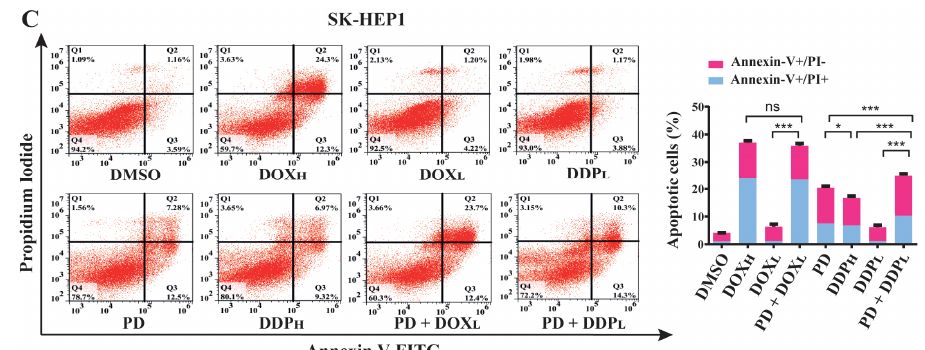
Figure 3. Evaluation of apoptotic rates in normal liver HL ‐ 7702 cells ( A ), HCC HepG2 ( B ) and SK ‐ HEP1 ( C ) cells using PD (300 μ M) and PD in combination with high or low dosages of DOX (0.2 and 1.5 μ M, as DOX L and DOX H , respectively) and DDP (5 and 30 μ M, as DDP L and DDP H , respectively). The cells were seeded and cultured overnight, and then treated by PD, DOX L , DOX H , DDP L and DDP H individually or combinatorially (PD + DOX L and PD + DDP L ) for 48 h. The cells were stained with Annexin V ‐ FITC and propidium iodide, then analyzed for apoptotic cell ratios using flow cytometry. Each sample was analyzed in triplicate, with similar results observed and representative data presented. The results are shown as the mean ± S.D. * p < 0.05, ** p < 0.01, *** p < 0.001, ns: not significant.